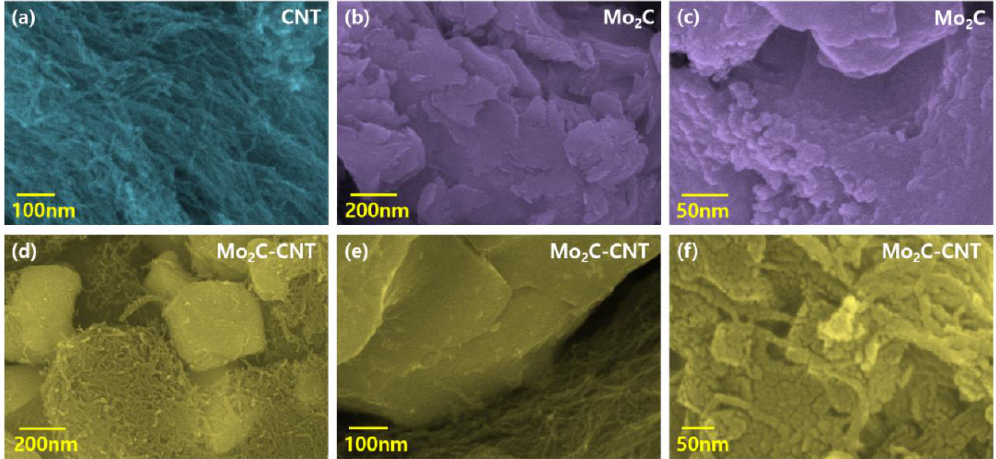
Figure 3. FESEM imagery of ( a ) CNT, ( b , c ) Mo 2 C, and ( d – f ) Mo 2 C@CNThybrid.